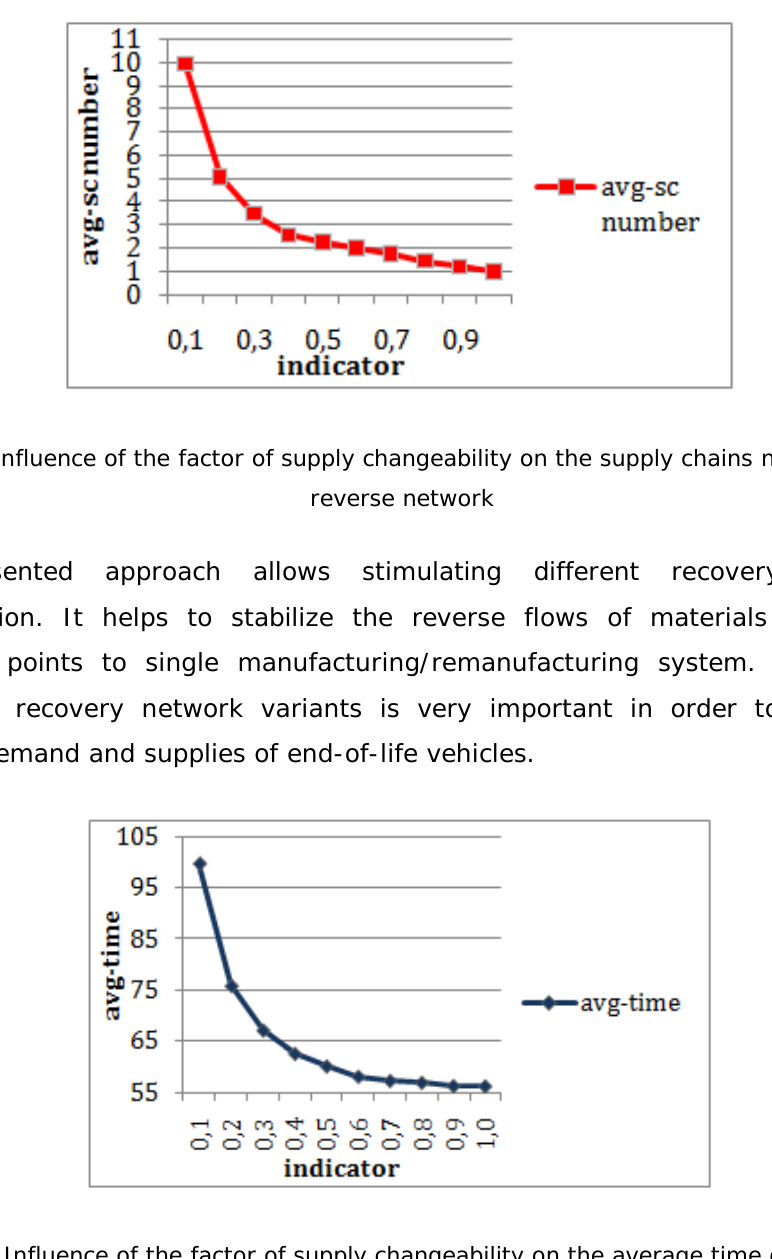
Figure 5. Influence of the factor of supply changeability on the average time of the whole process of the recovery in the